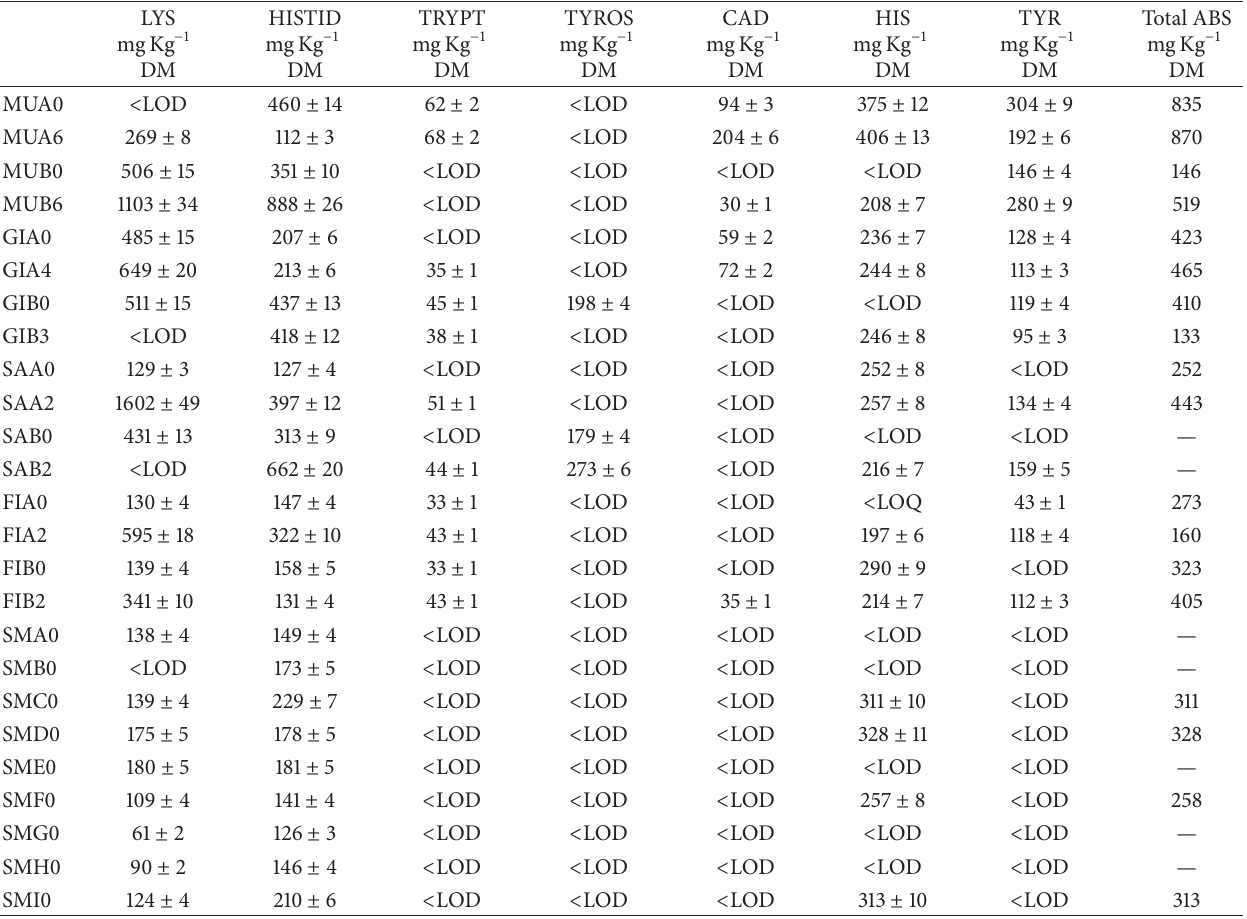
Table 2: Results of biogenic amines and precursor amino acids determination for the production and selling